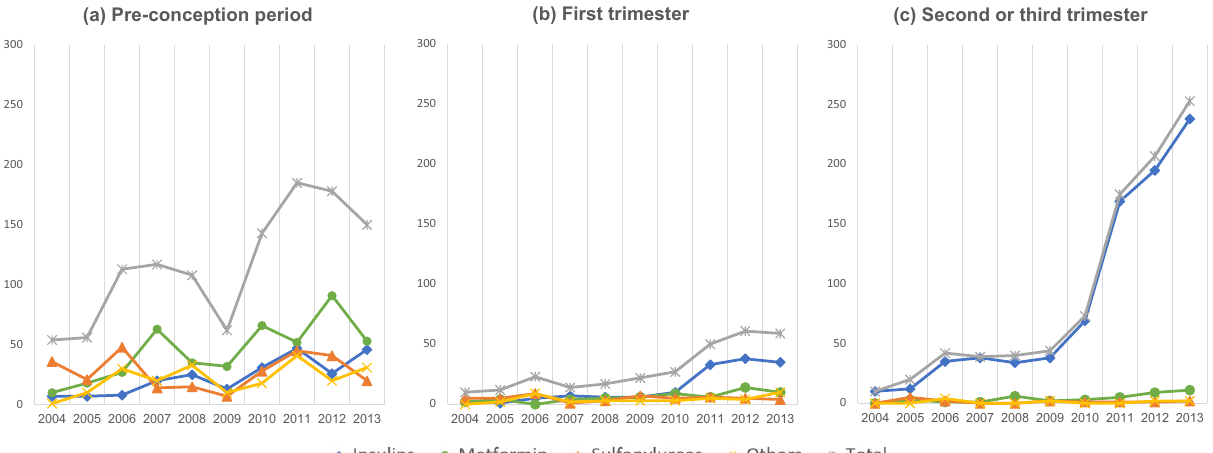
Figure 2. Secular patterns of antidiabetic prescriptions in the pre-conception period, first trimester, and second or third trimesters. *The y axis represents the number of prescriptions for each drug